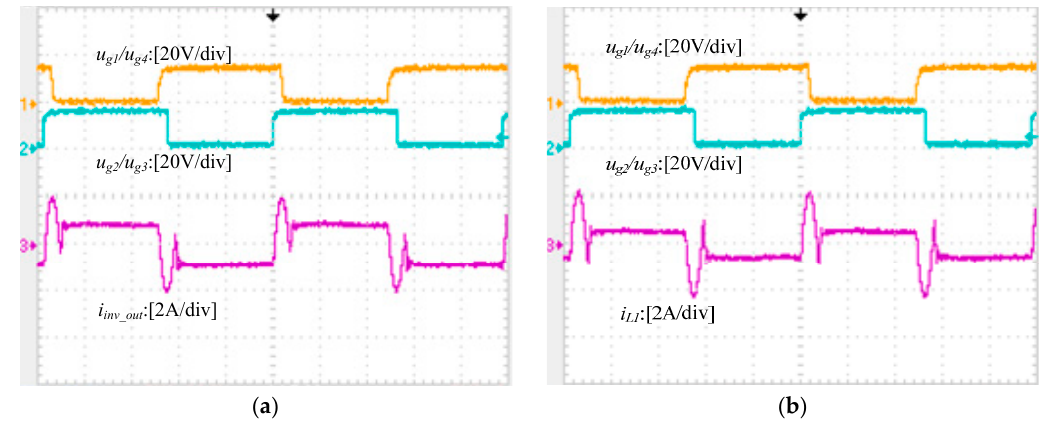
Figure 21. Steady-state waveform when M varies ( R L = 10 Ω , L 1 = 3.45 µ H): ( a ) 6 cm, M = 8.77 µ H; ( b ) 7 cm, M = 6.70 µ